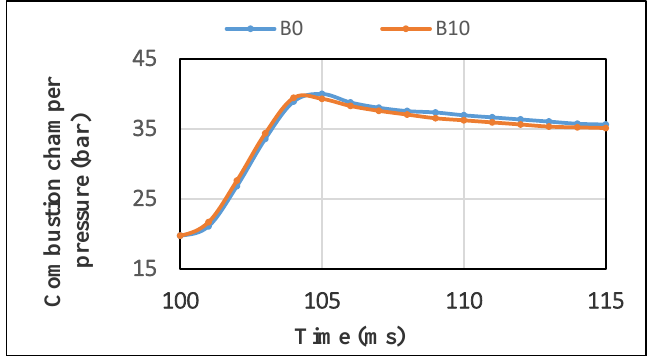
Figure 12. Progression of pressure in the CVCC combustion chamber.